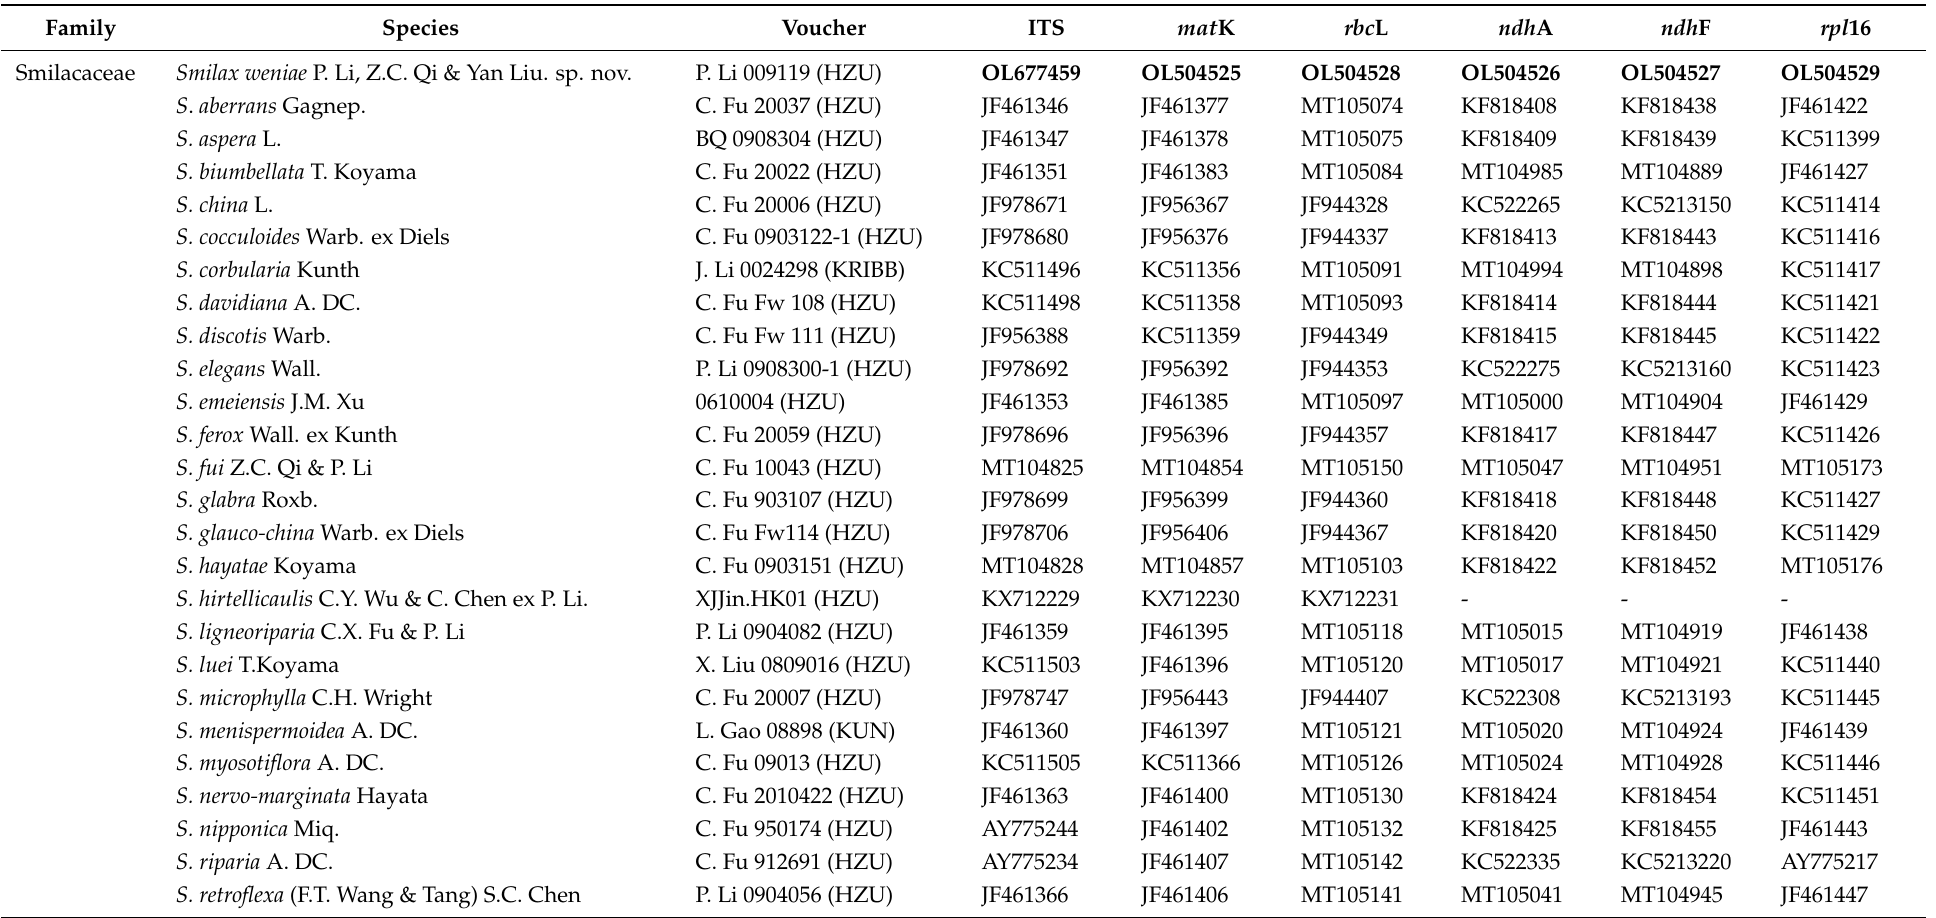
Table 2. Taxa included in the present study with voucher information and GenBank accession numbers for the sequences of internal transcribed spacer (ITS)